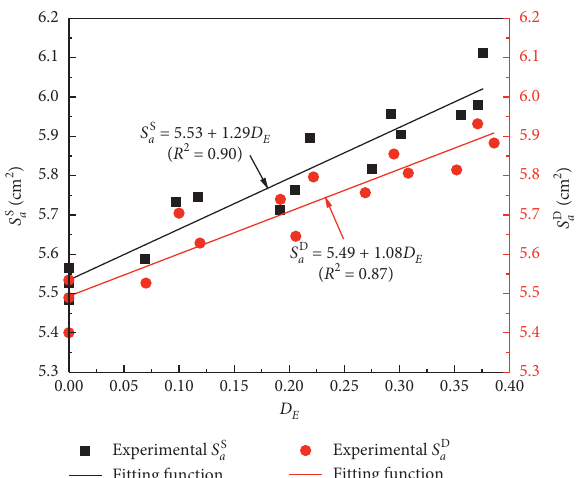
Figure 14: Relationship between the area of fracture surfaces and